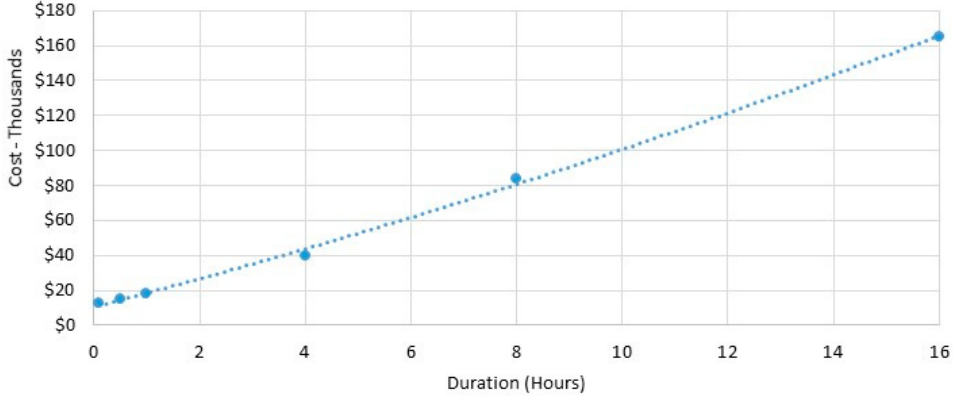
Figure 9. Value of lost load by outage duration to medium / large commercial and industrial customers.